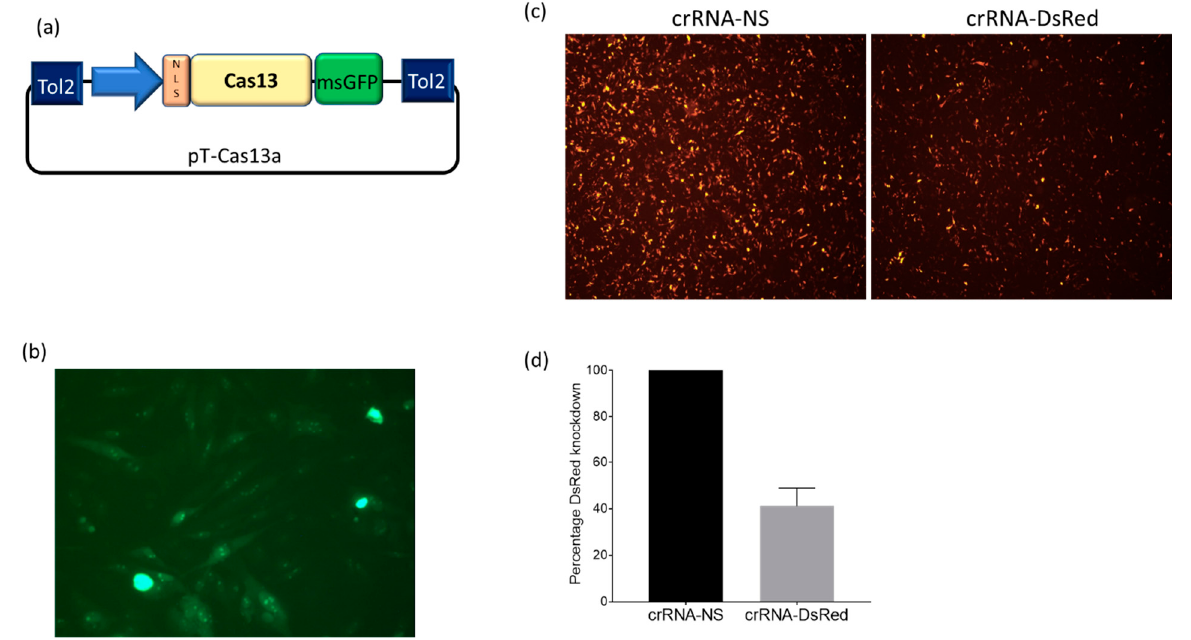
Figure 1. Evaluation of DsRed knockdown by Cas13a in stable DF1-Cas13a cells. ( a ) Schematic of pT-Cas13a vector carrying the Cas13-msGFP-NLS transgene insert sequence. ( b ) Fluorescence microscopy image of DF1-Cas13a cells transfected with pT-Cas13a and pTrans vectors. Stable GFP expressing cells were sorted using flow cytometry at 2 weeks post-transfection to generate a stable DF1-Cas13a cell line. ( c ) Fluorescence microscopy images of DF1-Cas13a cells transfected with 100 ng pDsRed and 900 ng of crRNA-DsRed or crRNA-NS. Images taken at 48 h post-transfection ( d ) Flow cytometry analysis of DsRed knockdown in DF1-Cas13a cells transfected with DsRed-crRNA or NS-crRNA 48 h post-transfection. The MFI values were normalized as a percentage of the negative control crRNA-NS (100%). Each value is the mean with standard deviation (2 replicates). Results are representative of 2 separate experiments (Figure S2).